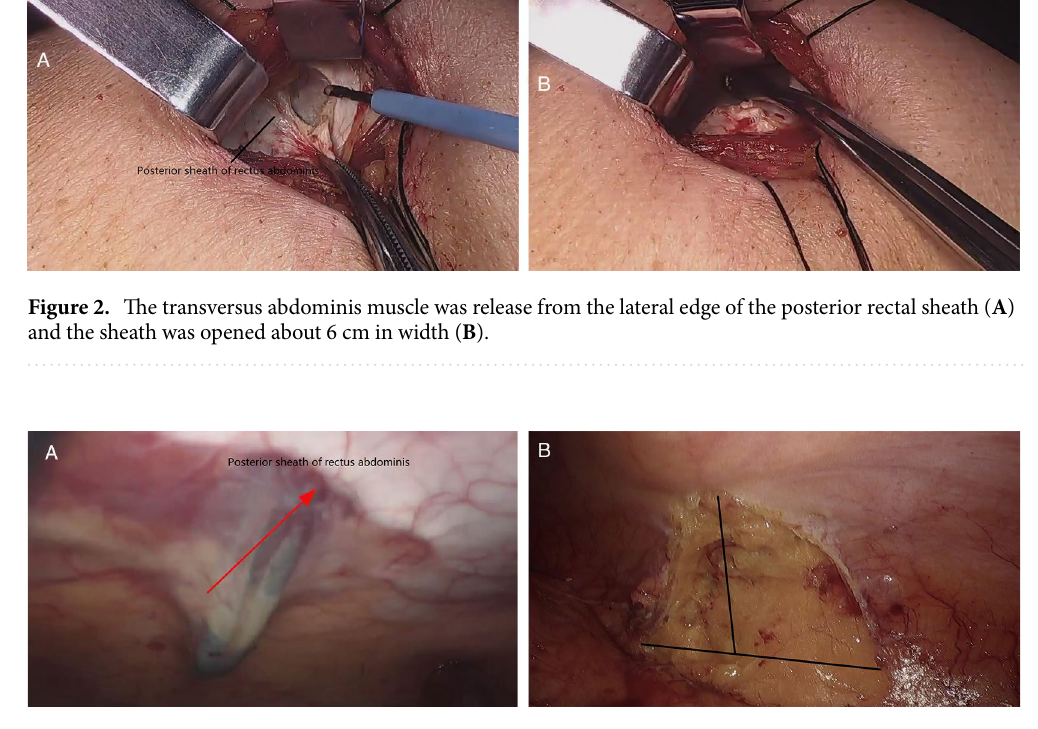
Figure 3. The extraperitoneal space was separated by a pair of curved Kelly forceps ( A ) and the peritoneum inside the abdominal cavity is opened in a reverse “T” type ( B